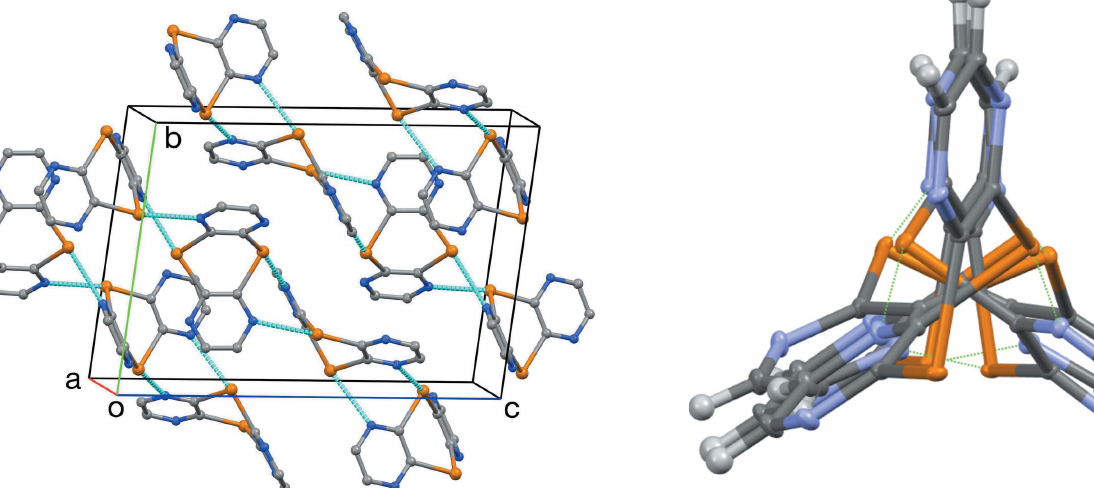
Figure 4 View of chain along the helix